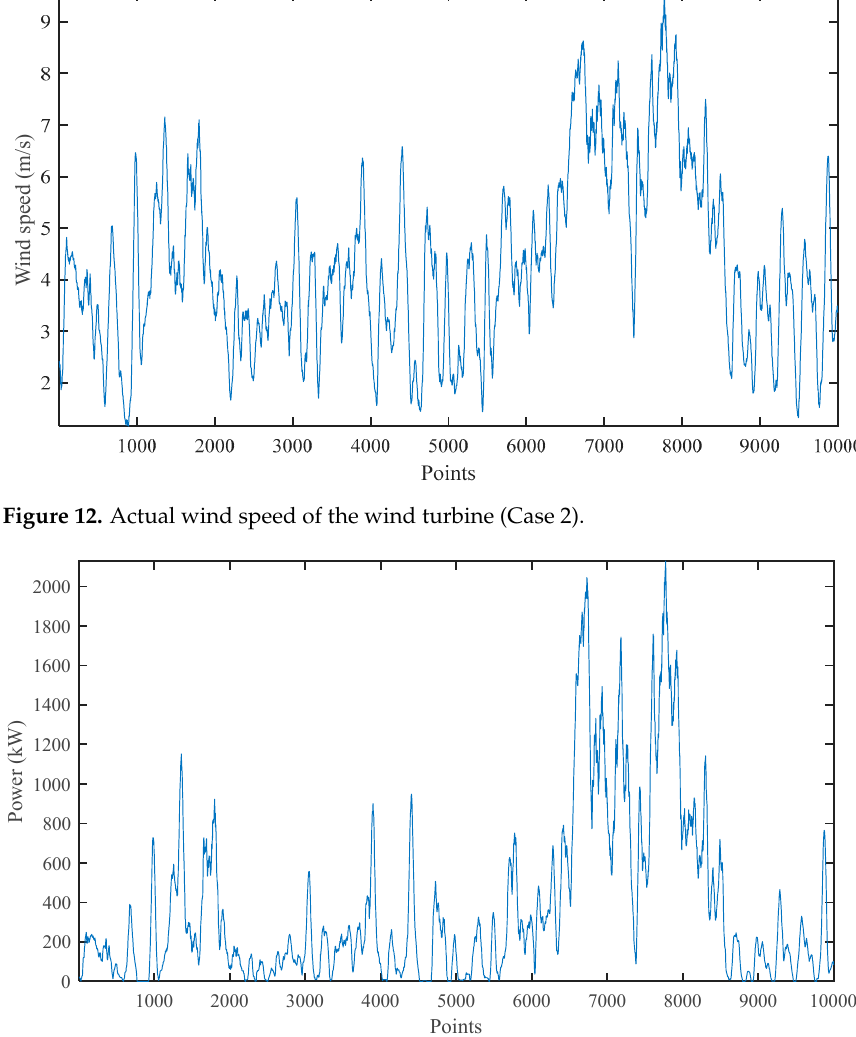
Figure 13. Actual power generation of the wind turbine (Case 2).